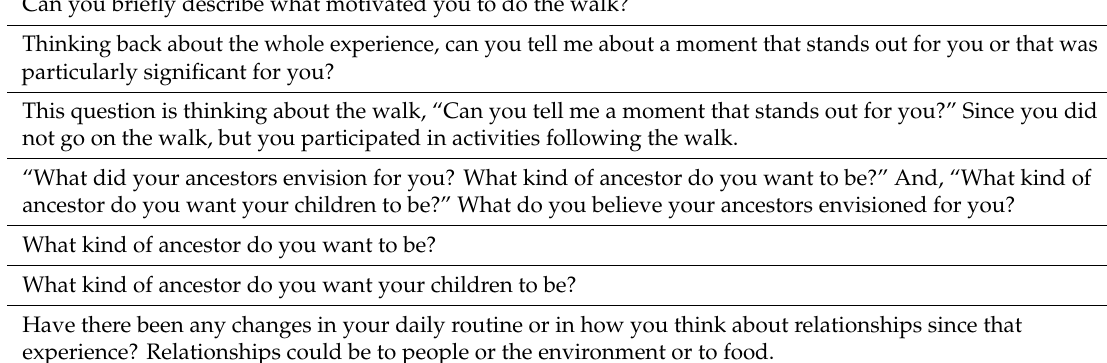
Table 2. UHN Returning to Our Roots semi-structured interviews and participant questions as used in the Yappalli